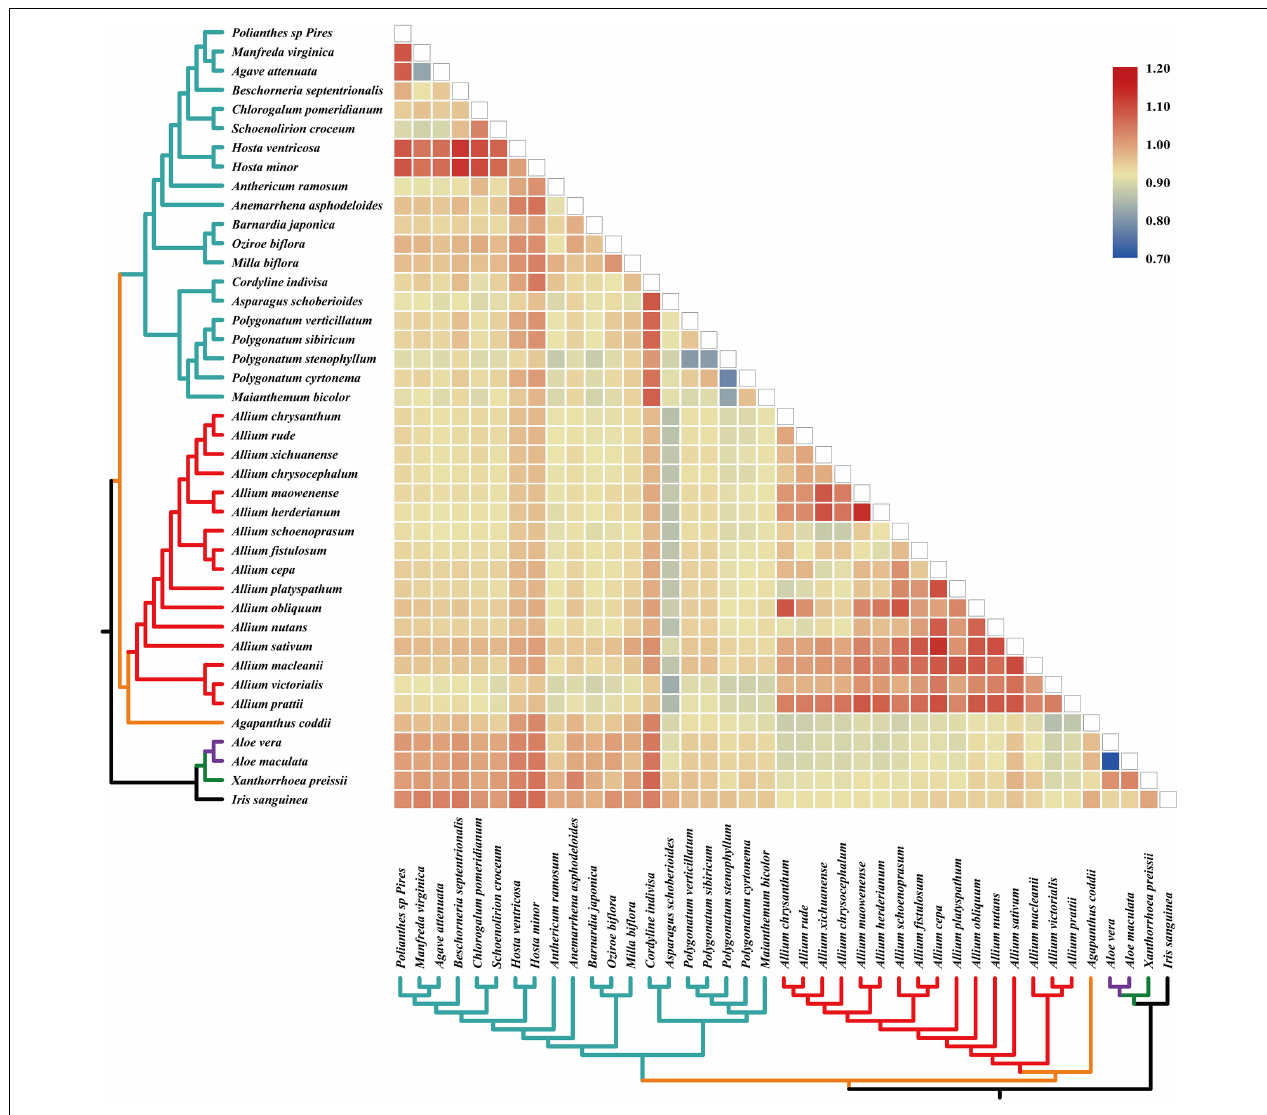
FIGURE 4 | Pairwise Ka/Ks ratios in Allium (Allioideae) and other families. This heatmap shows pairwise Ka/Ks ratios between every sequence in the multigene nucleotide alignment. Allium (Allioideae) are shown on red branches. The scale factors associated with each value are shown on the right-hand side of the